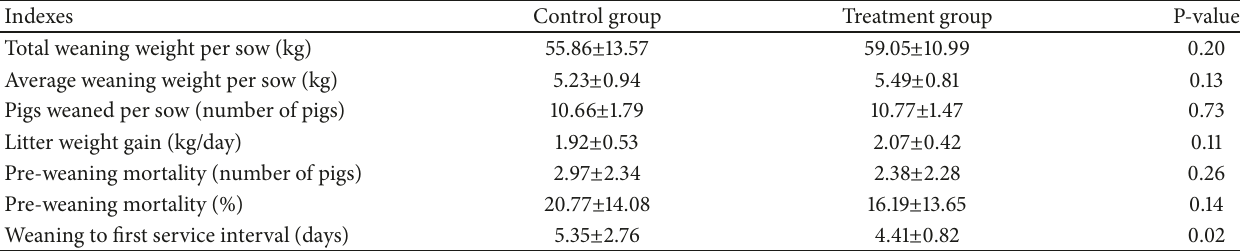
Table 2: Production indexes of the control group (no suckling sound; n=15) and treatment group (suckling sound; n=15) (mean ± SD) also.